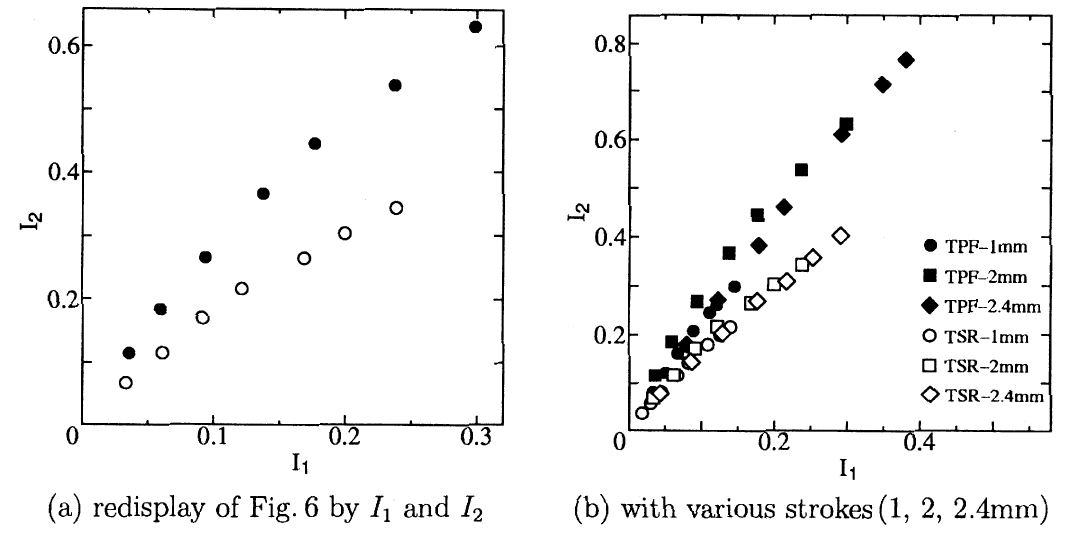
Fig. 7. Output of PVDF1 ( I 1 ) versus that of PVDF2 ( I 2 ) on triangular objects of plastic foam and sponge